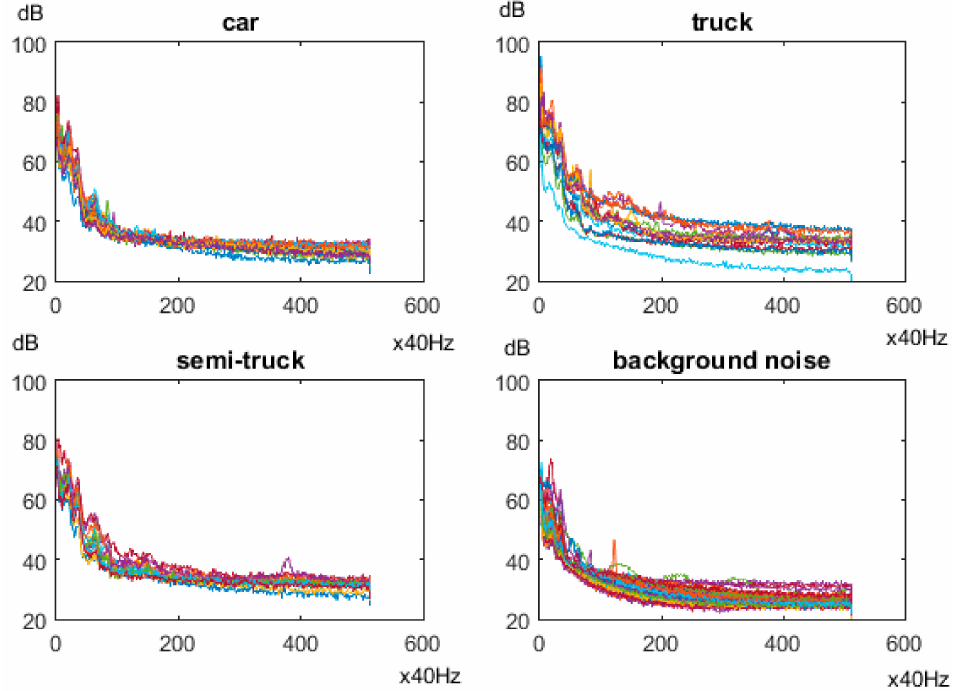
Figure 8. Sound spectra for vehicles of different classes and for background